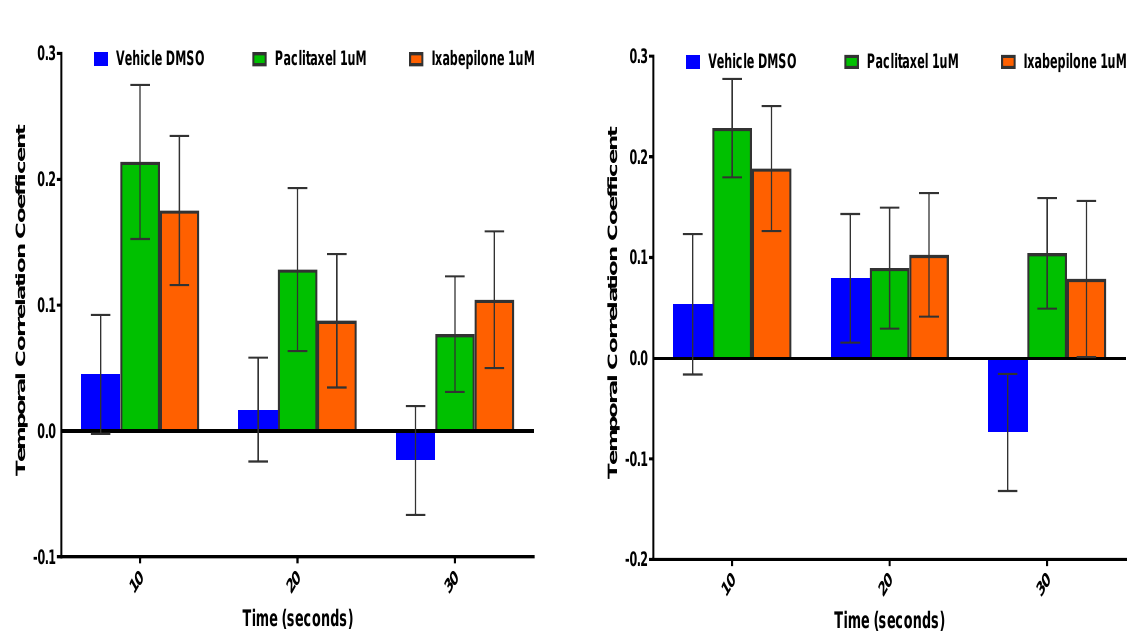
Figure 5. Temporal correlation coefficients following treatment of ovarian clear cell (OCCC) (i.e., TOV21G, class III ß-tubulin highexpressor) and serous (OSC) (i.e., OVASHO, class III ß-tubulin non-expressor) cell lines with paclitaxel and ixabepilone ( n = 20). Mean with standard error of the mean are shown.